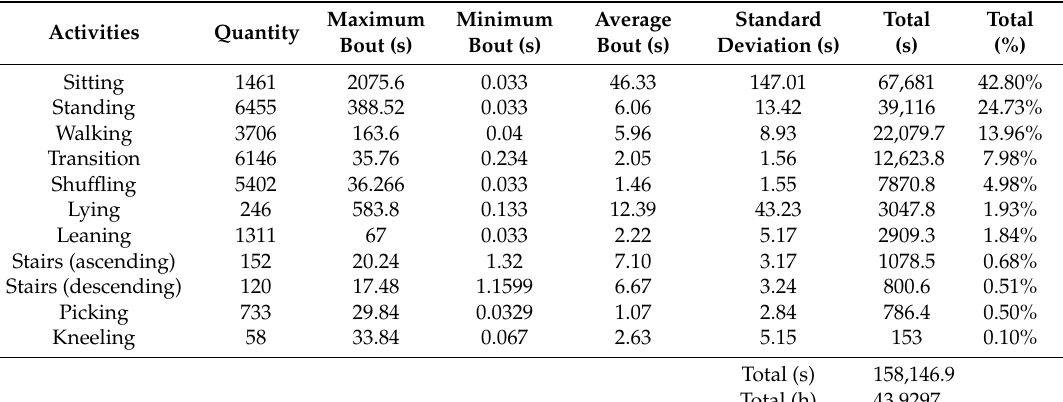
Table 12. Summary of the in-lab and out-of-lab activities, excluding Undefined, Static, Dynamic, Shake and